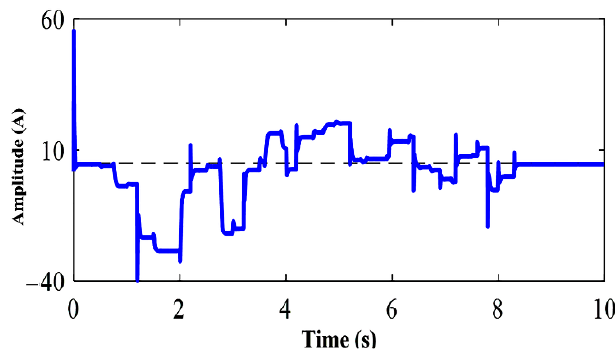
Figure 7. Capacitor bank voltage in the presence of SDRE controller.